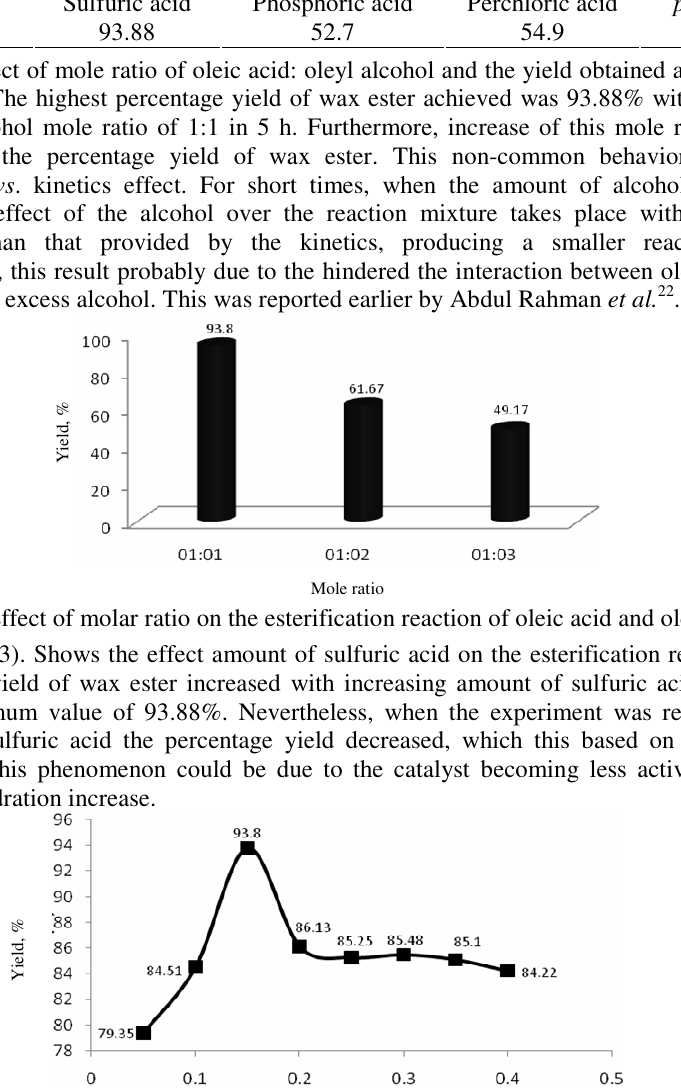
Ester yield, % Duration